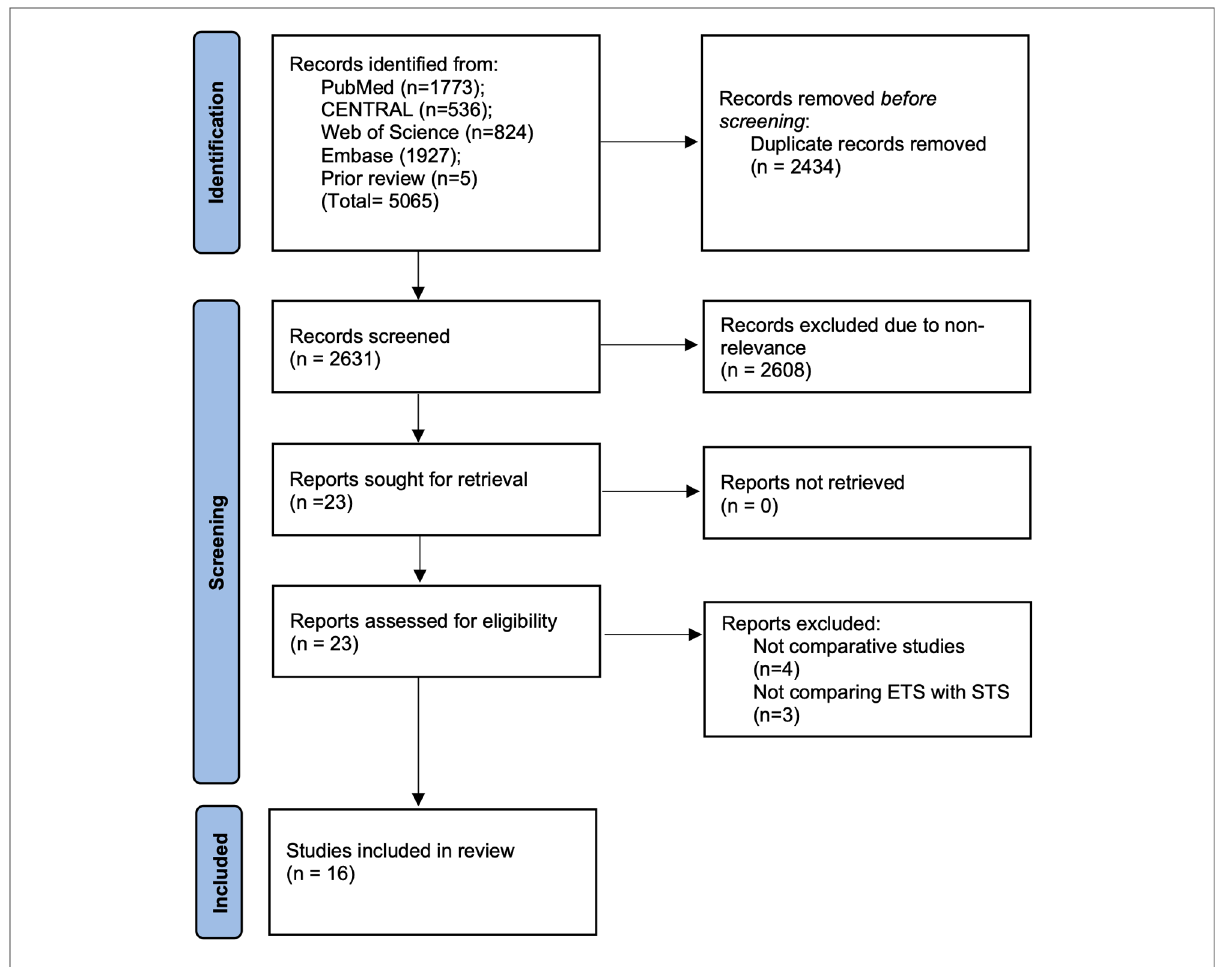
FIGURE 2 Study fl ow